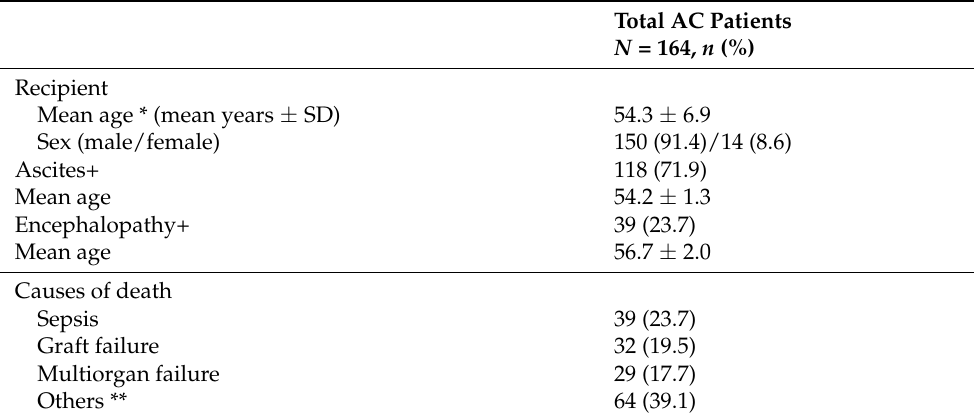
Table 1. Baseline demographic, clinical, and biochemical characteristics of the male AC patients were analyzed in this study.